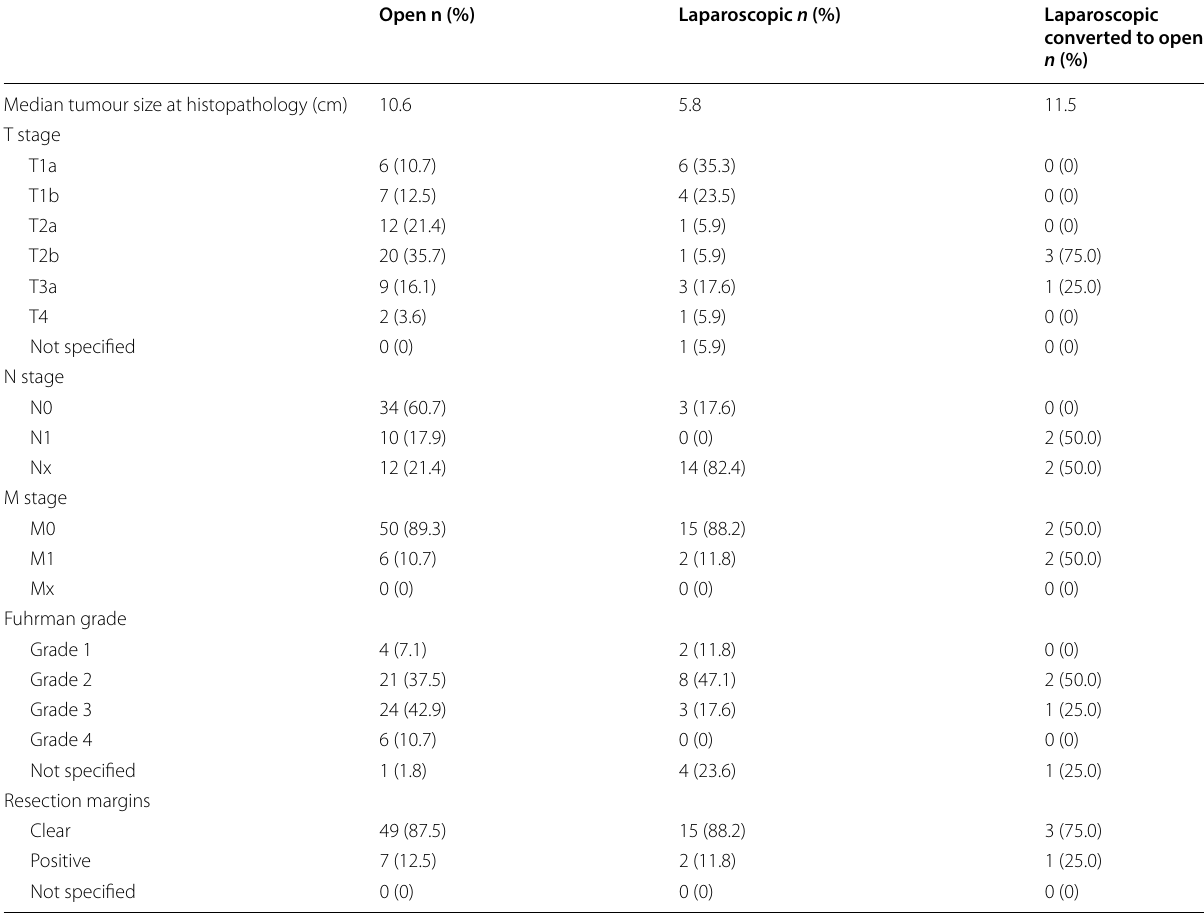
77) = Open n (%) Laparoscopic n (%) Laparoscopic